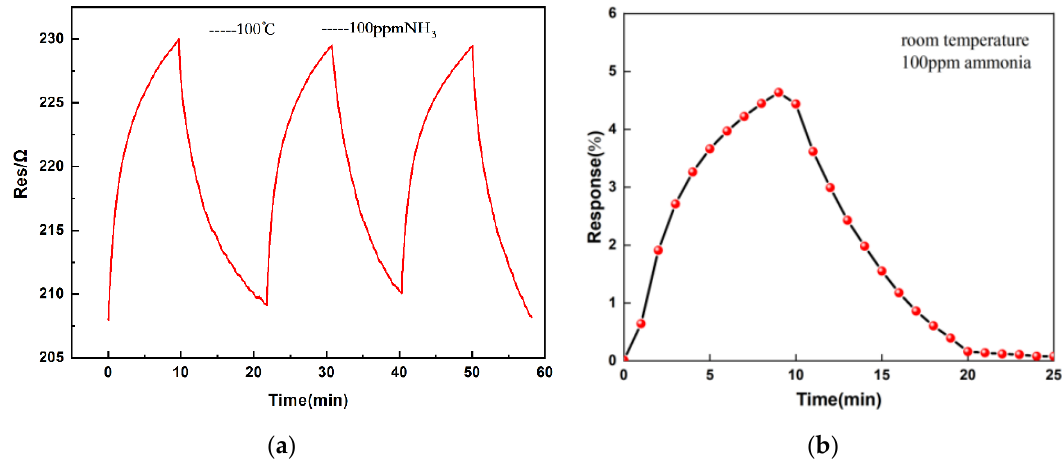
Figure 6. Response of the IDE for 100 ppm of NH 3 gas at 25 °C. ( a ) The resistance of the sensor with time. ( b ) The response of the sensor.